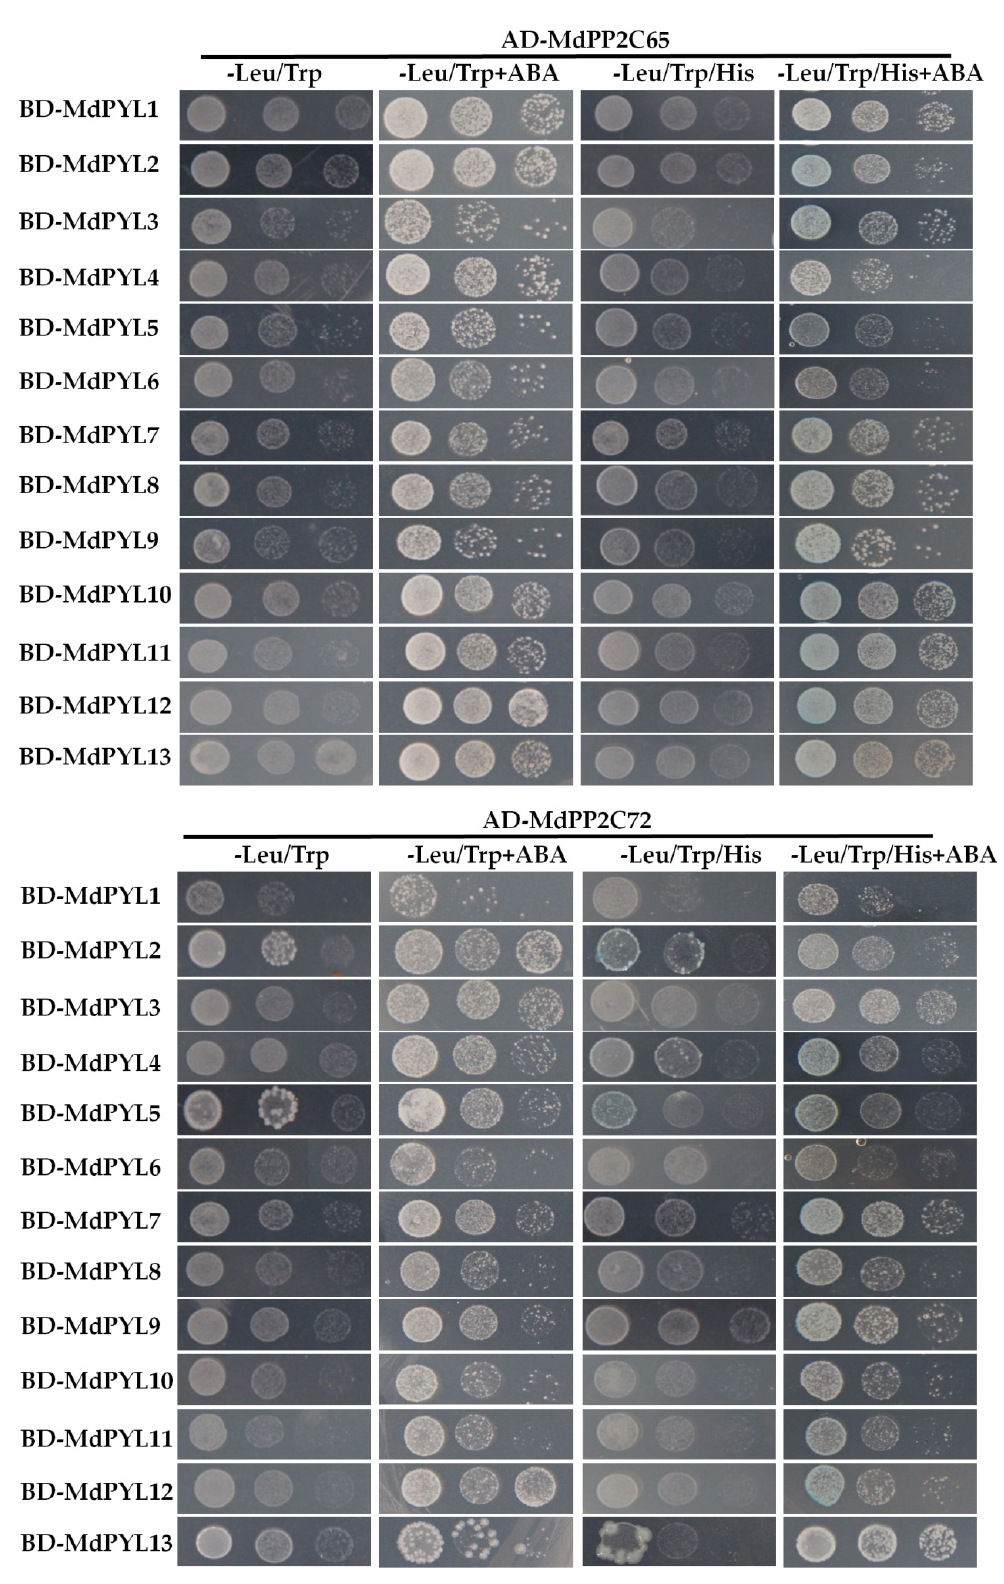
Figure 10. Interactions between MdPYLs and MdPP2Cs in yeast. Co-transformed positive yeast cells dilutions (10 − 1 , 10 − 2 , and 10 − 3 ) were spotted onto the plates. Interaction was determined by growth assay on SD-Leu/-Trp/-His/X- α -Gal/3-AT medium in the presence and absence of 10 μΜ ABA.